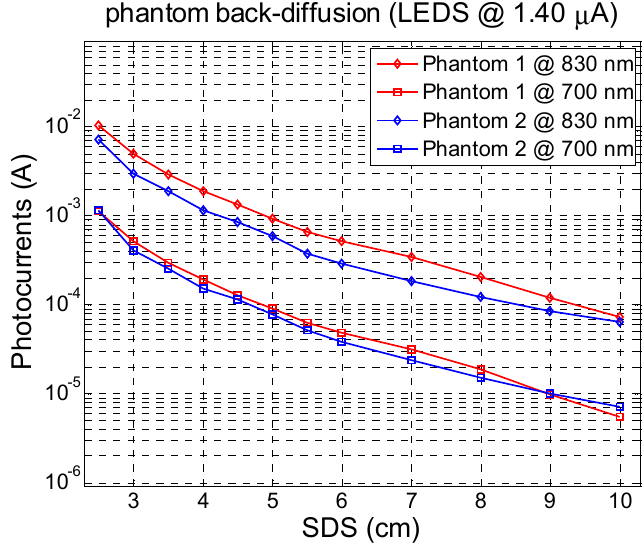
Figure 3. SiPM photocurrents measured on the phantoms at multiple source detector separations (SDSs) under 700 nm and 830 nm illumination.